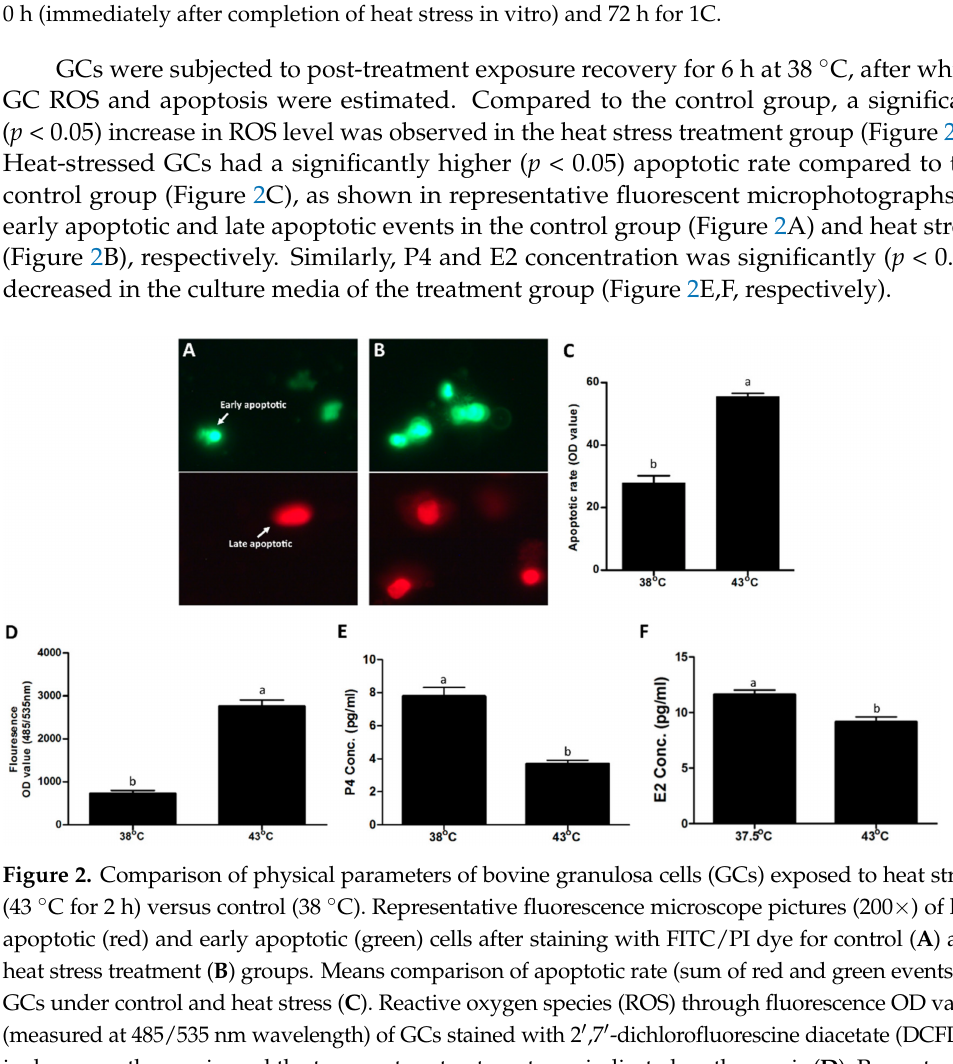
Figure 1. Comparison of physical parameters of bovine granulosa cells (GCs) exposed to heat stress (43 ◦ C for 2 h) versus control (38 ◦ C). GC proliferation curves with mean optical densities (ODs) measured at 450 nm wavelength are plotted against different recovery time points in hours (hrs) for control ( A ), heat stress group with delayed medium change ( B ) and heat stress group with immediate medium change ( C ). Means without common letters (a, b, c, d) are significantly different ( p < 0.05; n = 6 independent cultures). “MC” indicates culture media change at 48 h and 96 h in 1A and 1B, and 0 h (immediately after completion of heat stress in vitro) and 72 h for 1C.